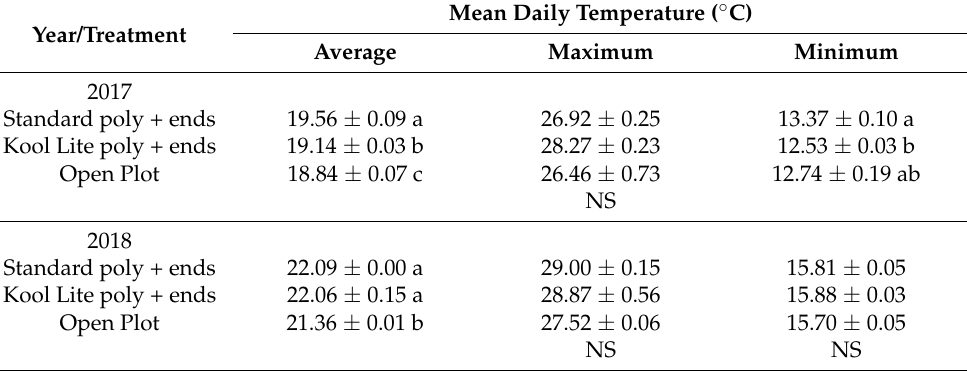
Table 5. Mean temperatures one week before and after sample data collection for P. japonica adults in ‘Heritage’ autumn-bearing raspberries grown under high tunnel structures, Rosemount, MN, 2017 and